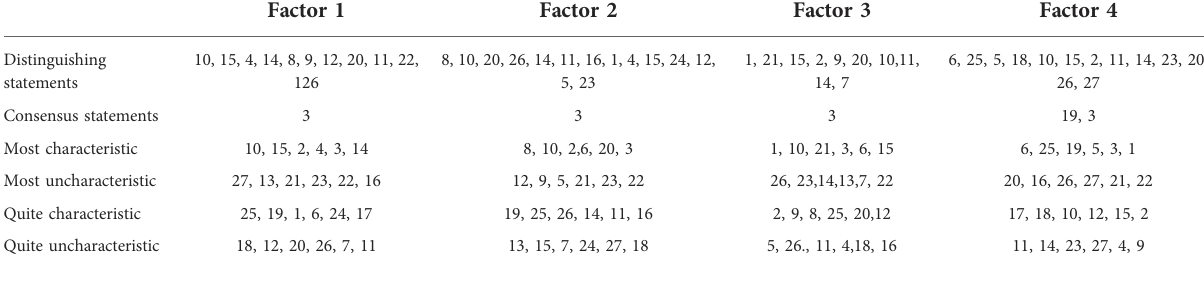
TABLE 2 Classi fi cation of the statements according to the Q method. The 4 factors extracted represent the 4 main pools of opinions in the total group of participants included in the study. Factor